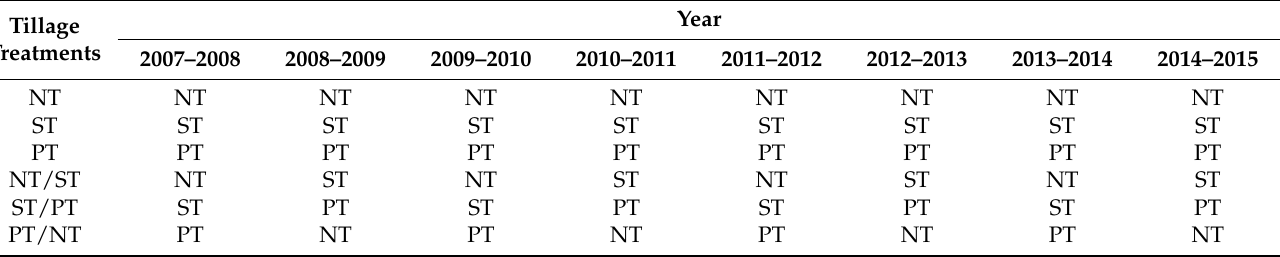
Table 1. The soil tillage treatments in